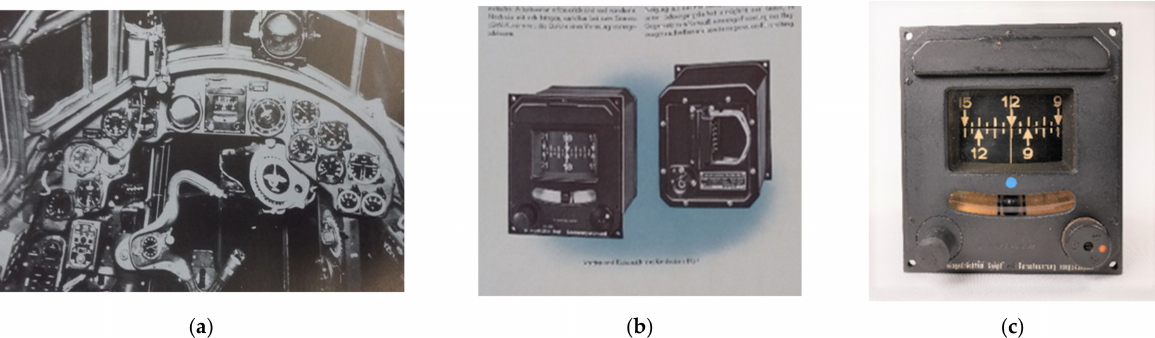
Figure 25. The LKu4 by Siemens: ( a ) mounted in a Junkers JU 88 A-1 cockpit; ( b ) a Siemens advert from the early 1940s; and ( c ) front view of the Gyrolog asset.